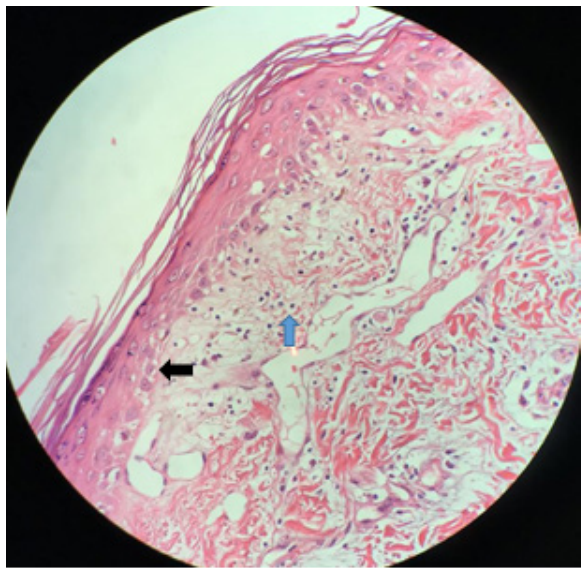
Figure 3. Presence of edema in papillary dermis (blue arrow), and hydropic degeneration of basal cells (black arrow) in cutaneous DLE (magnification ×400). Note . DLE: Discoid lupus erythematosus.